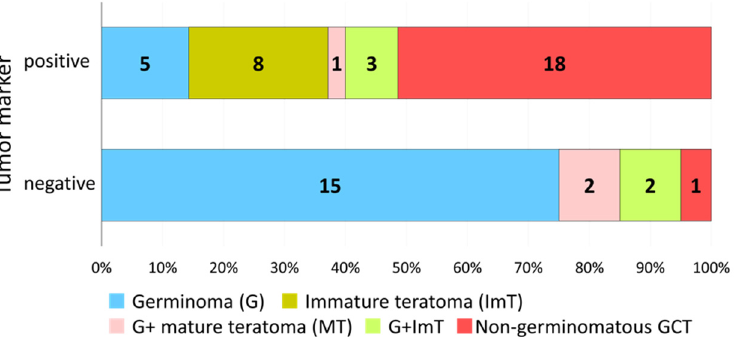
Figure 2. The distribution of the histology in marker-positive (either one or both of the tumor markers in serum or cerebrospinal fluid were positive) and marker-negative cases (both tumor markers were negative) is shown. About half (17 of 35, 49%) of the marker-positive cases did not demonstrate a malignant component on histopathological analysis. Twenty-two cases did not have both tumor markers checked; correspondingly, although the one level that was assessed was negative, these patients were not designated among the definitively marker-negative cases. Table 1. Clinical characteristics and follow-ups of 17 cases with positive tumor markers and no ma- lignant non-germinomatous histopathological component, obtained from large resection specimens. Histopathologic Tumor al Diagnosis Location